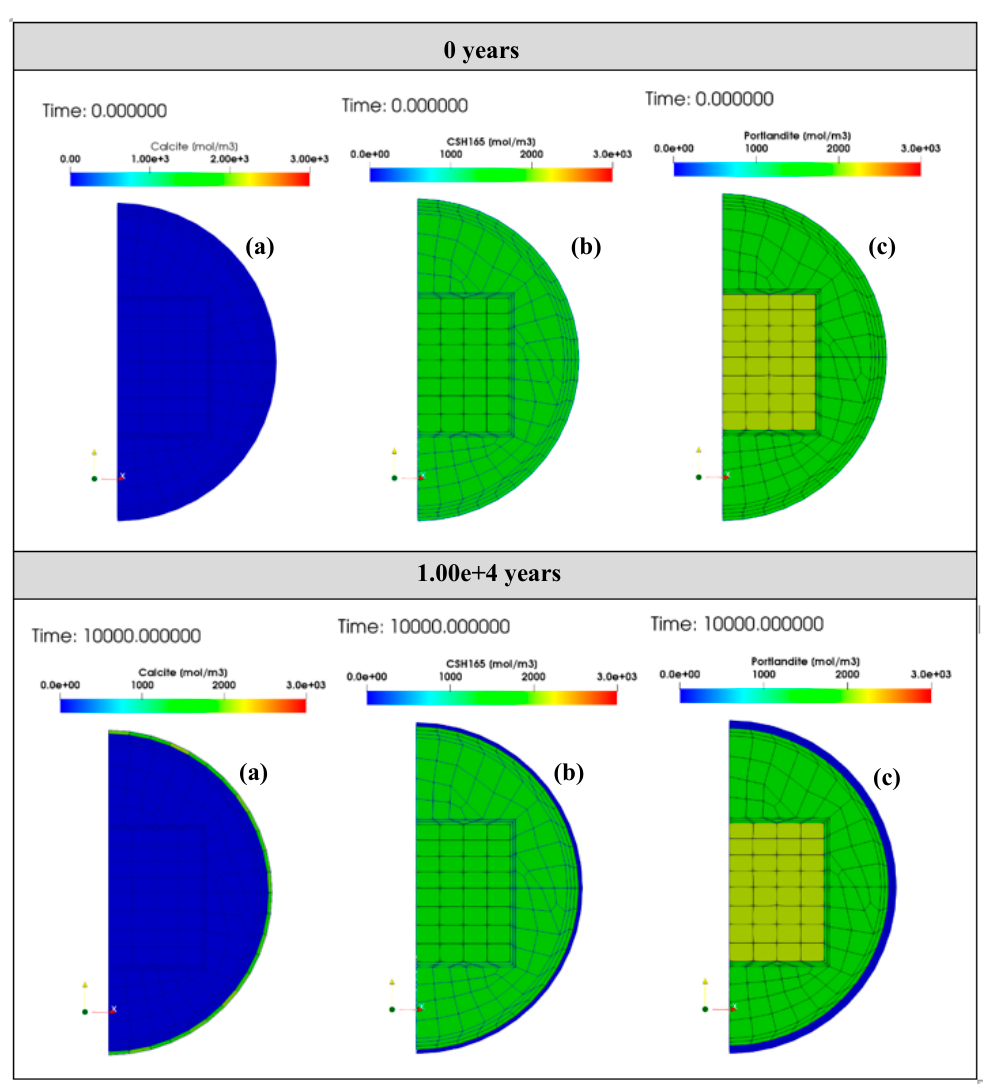
Figure 10. Profiles at 0 years (top) and 10,000 years (bottom) of: ( a ) calcite, ( b ) C-S-H 165 and ( c ) portlandite.